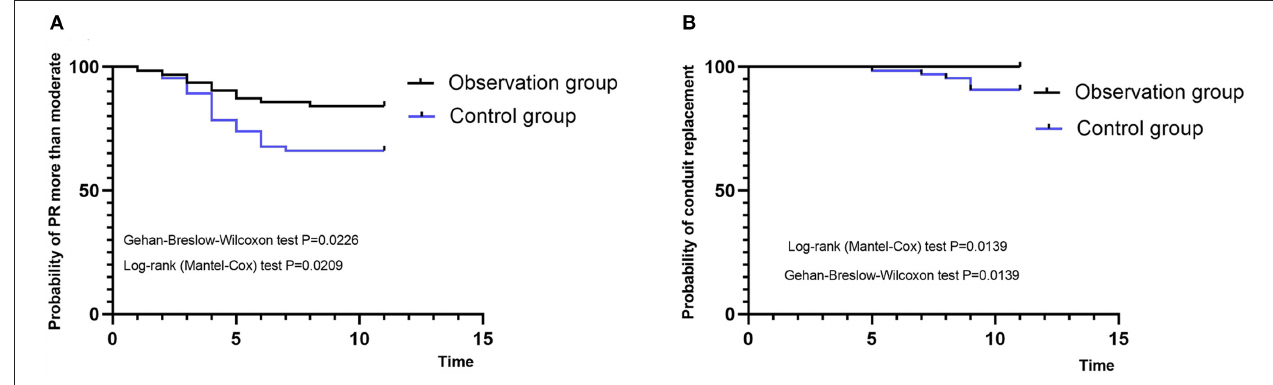
FIGURE 3 | Kaplan-Meier curves. (A) Probability of moderate and serious pulmonary regurgitation. (B) Probability of reoperation. PR, pulmonary regurgitation.